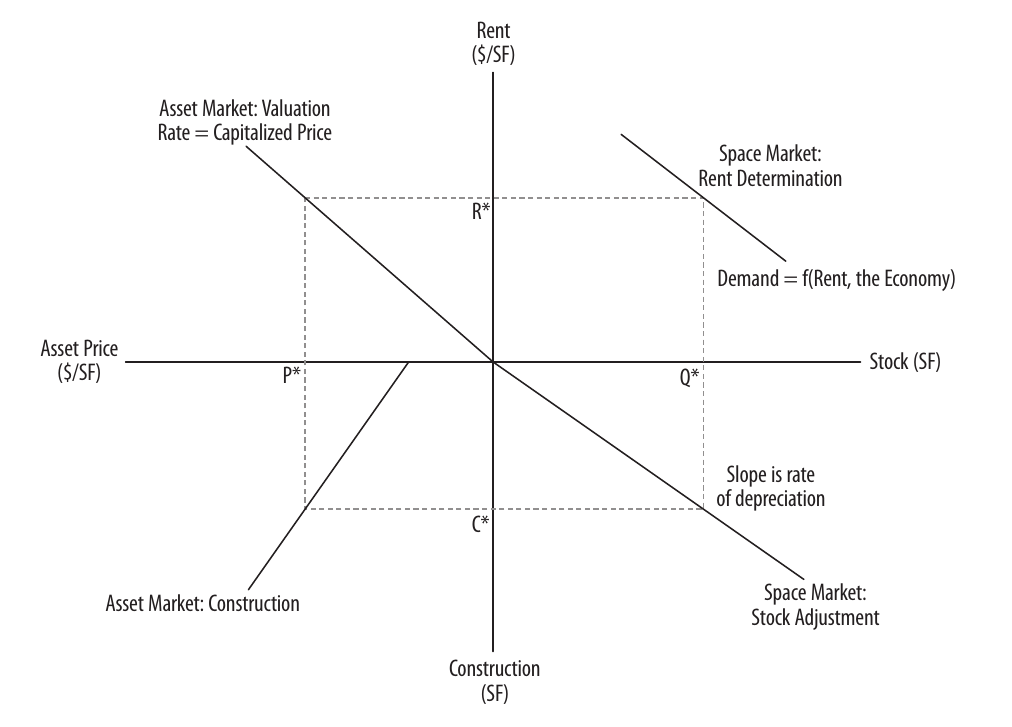
Figure 2. The Four-quadrant model of diPasquale and Wheaton